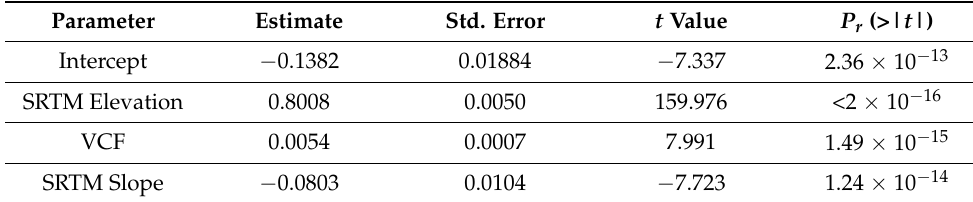
Table 1. Regression coefficients for regression model